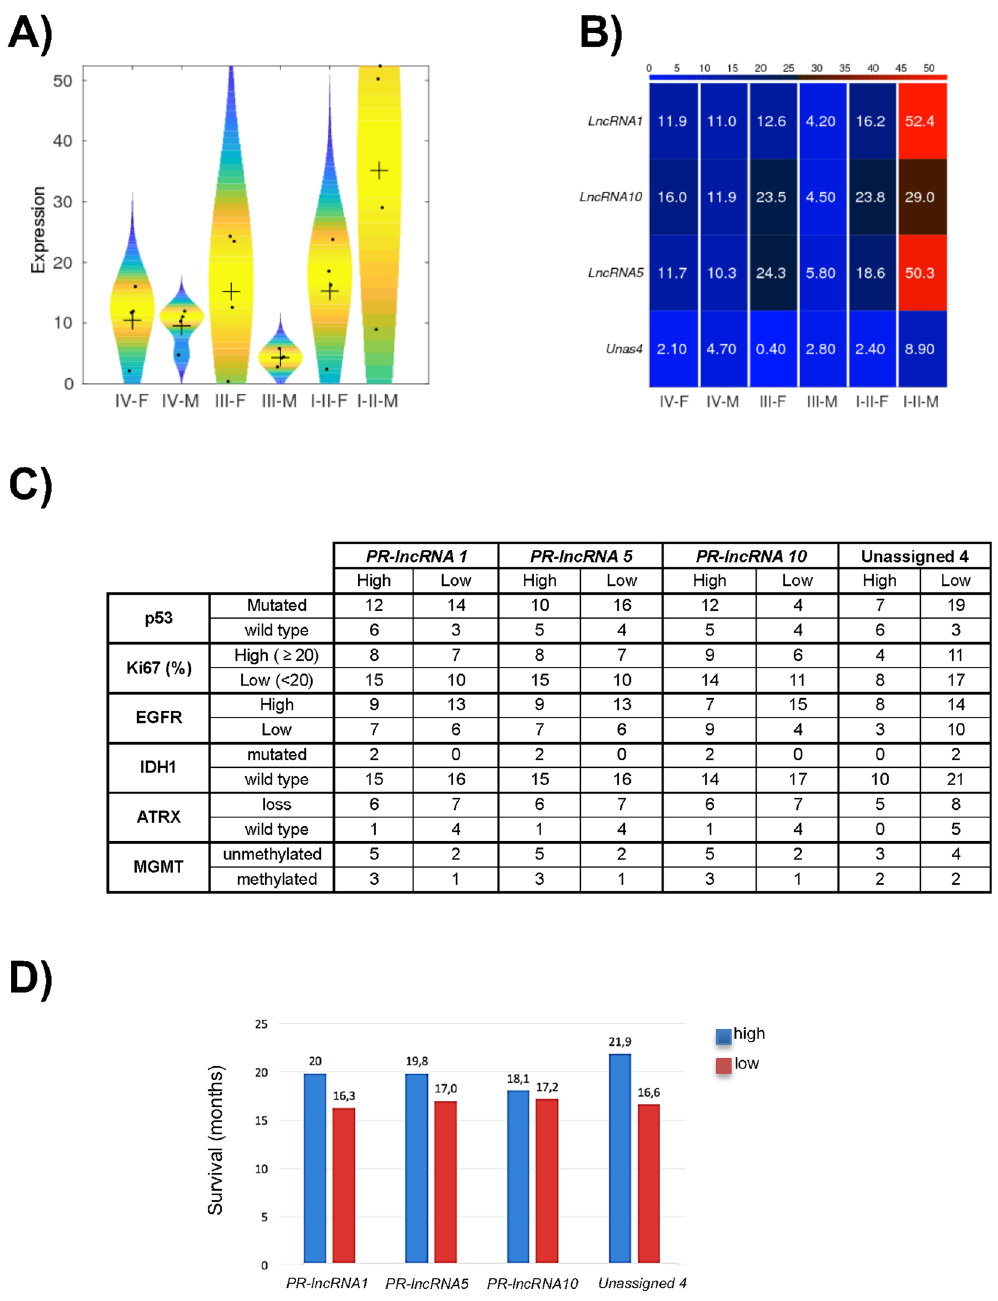
Figure 2. Correlation between PR-LncRNA expression and patient clinical characteristics. ( A ) Violin plot associated to the distribution of the expression of the PR-LncRNAs in gliobastoma (IV), anaplastic (III) and low- grade glioma (II) separated by sex (M - male, F - female). The + denote the mean values of the distributions and the black dots are the expression values. ( B ) Heat map of the expression of the studied PR-LncRNAs separated by sex. Redder color corresponds to higher expression. The colorbar on the top codifies the expression level. ( C ) Correlation between expression of PR-LncRNAs and molecular markers frequently altered in glioma, namely, p53, Ki67, EGFR, IDH1, ATRX and MGMT. ( D ) Median overall survival stratified by level of each of the PR- LncRNAs